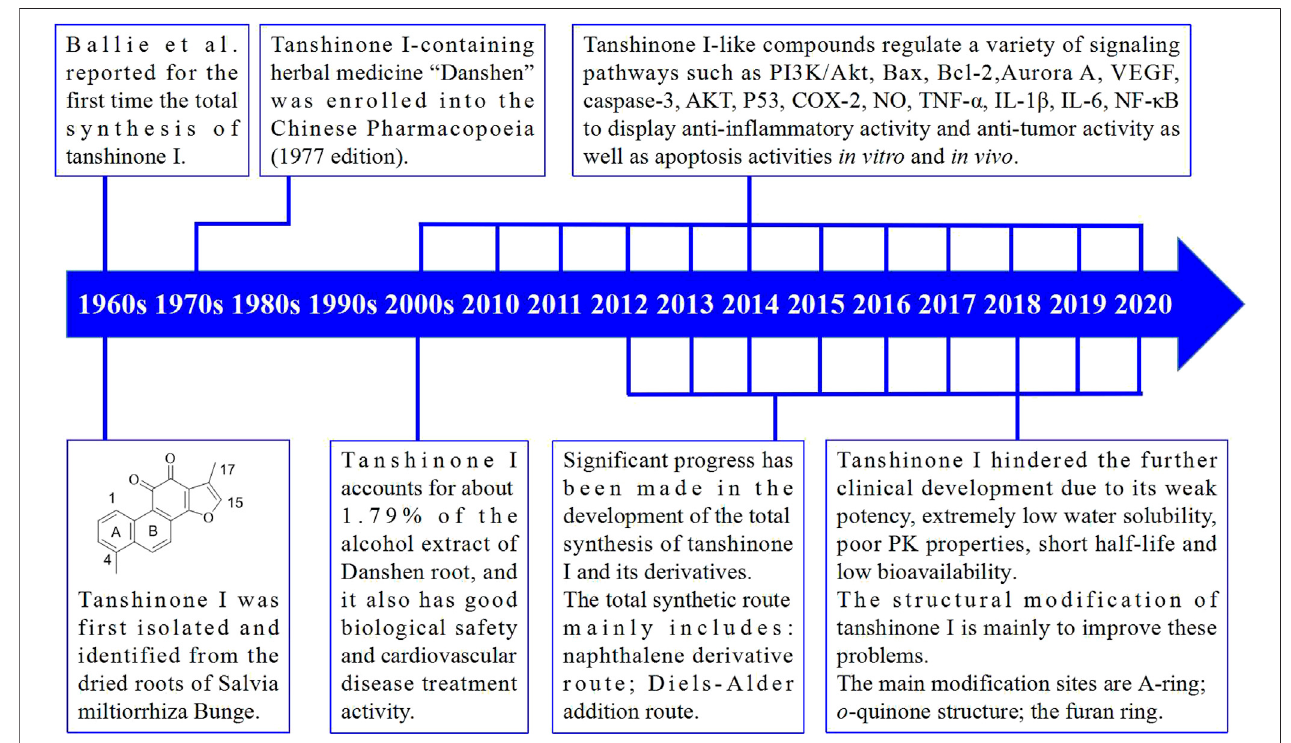
FIGURE 3 | Major milestones achieved in tanshinone I-inspired drug discovery and